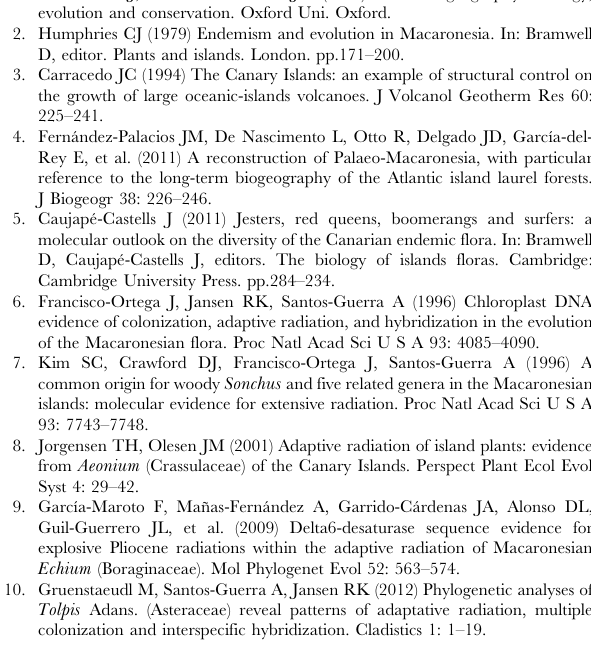
Figure S1 Principal coordinates (PCoA) plot of AFLP data for the Macaronesian Cheirolophus populations included in this study. Different symbols correspond to different populations as shown in the legend in the right side. Some populations groups that are well-differentiated and/or mentioned in the text are circled and named. Table S1 Sampling information and genetic diversity indexes assessed. Taxa, locality, code, number of sampled individuals (N), and genetic diversity indexes assessed by AFLP in 29 populations of Cheirolophus from Macaronesia. Genetic indices: number of private fragments (f u ); heterozygosity (Hj); percentage of polymorphic loci for a standardised sample size of